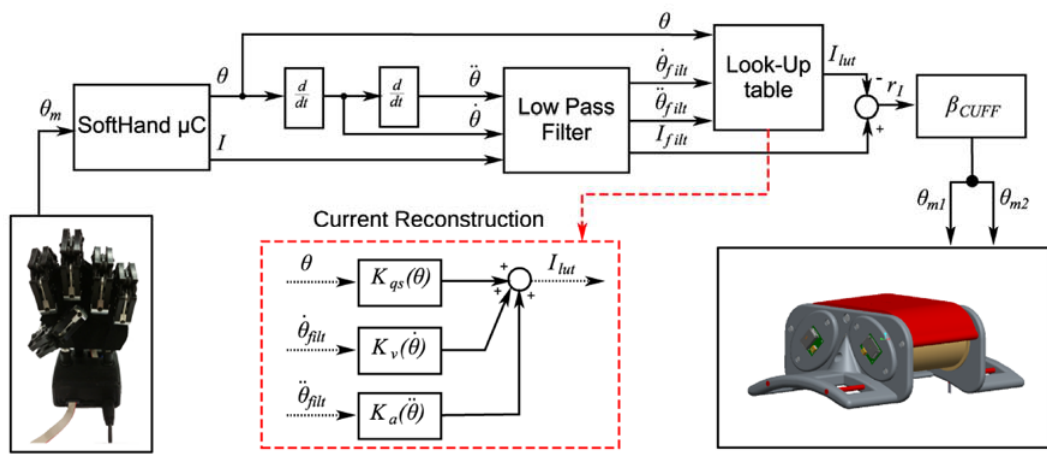
Figure 6. CUFF reproduces the estimated resultant force applied by SoftHand through belt stretching over a user’s arm. The suffix filt on signals indicates the measured current, velocity, and acceleration of SH after low pass filtering. Reproduced from [14], Copyright 2013, IEEE.